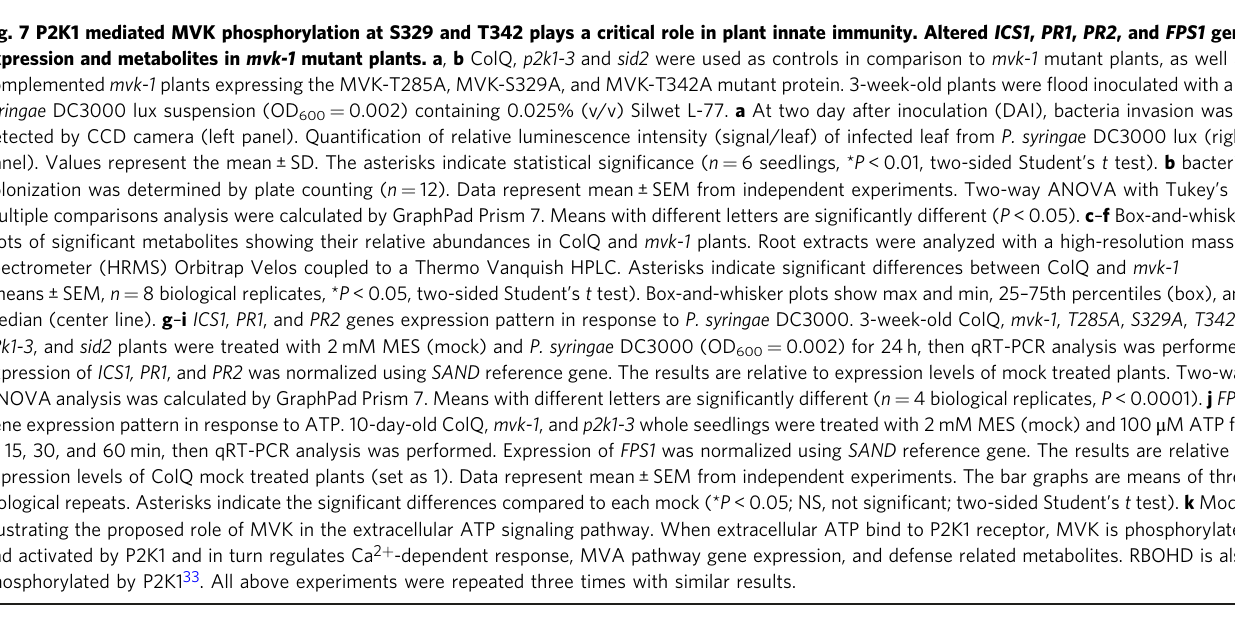
Fig. 7 P2K1 mediated MVK phosphorylation at S329 and T342 plays a critical role in plant innate immunity. Altered ICS1 , PR1 , PR2 , and FPS1 gene expression and metabolites in mvk-1 mutant plants. a , b ColQ, p2k1-3 and sid2 were used as controls in comparison to mvk-1 mutant plants, as well as complemented mvk-1 plants expressing the MVK-T285A, MVK-S329A, and MVK-T342A mutant protein. 3-week-old plants were fl ood inoculated with a